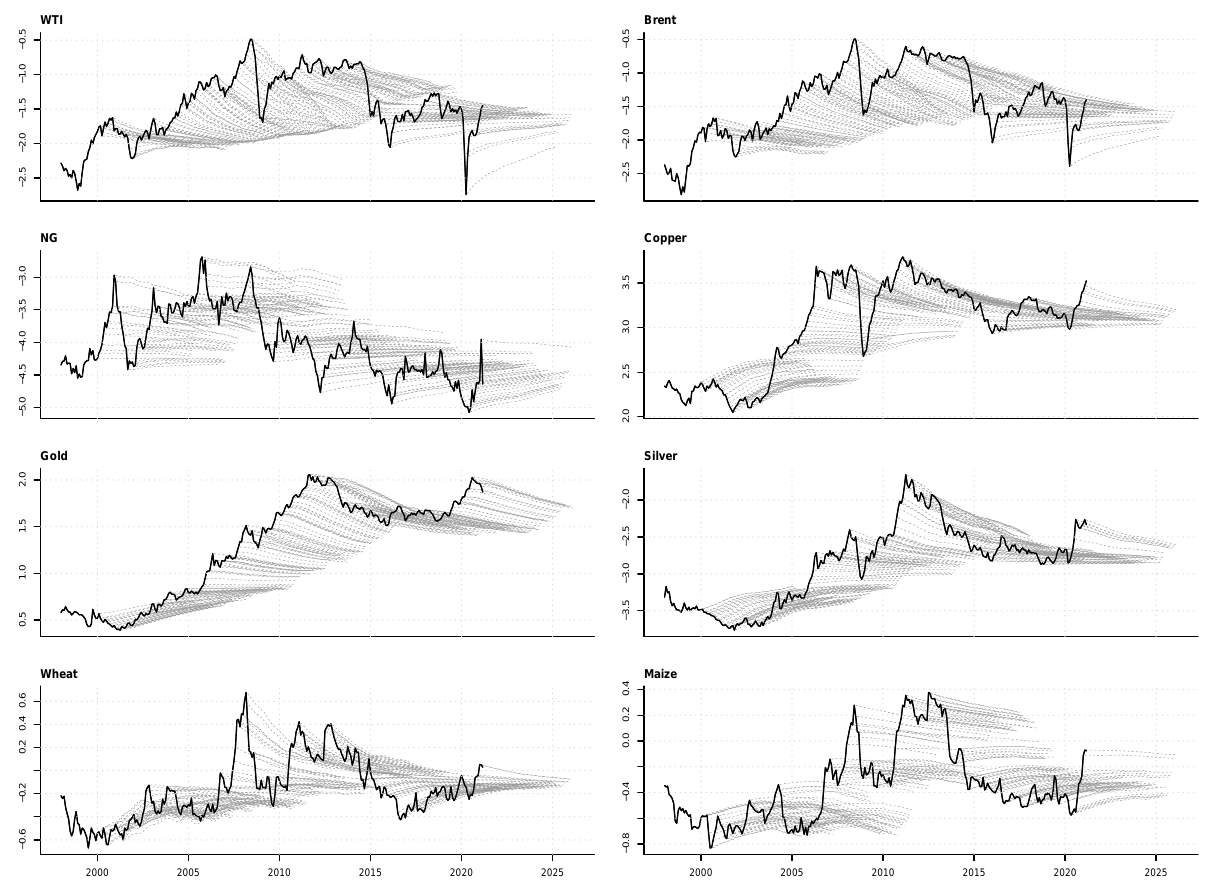
Figure 2. Sequential forecasts for real commodity prices. Notes: The figure presents recursive local projection-based forecasts for the log of real commodity prices. Forecasts with 1 to 60 month horizons are evaluated using data from the period January 2000–March